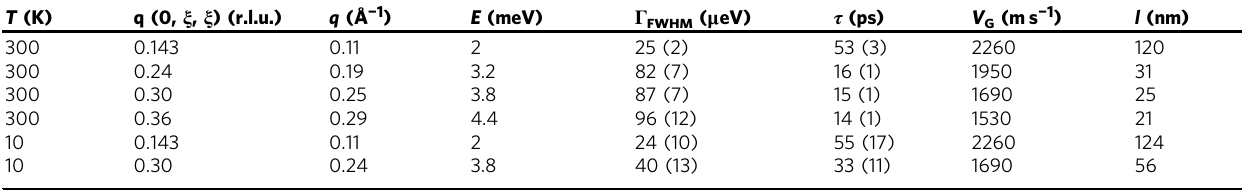
individual phonons properties Ba 7.81 Ge 40.67 Au 5.33 011